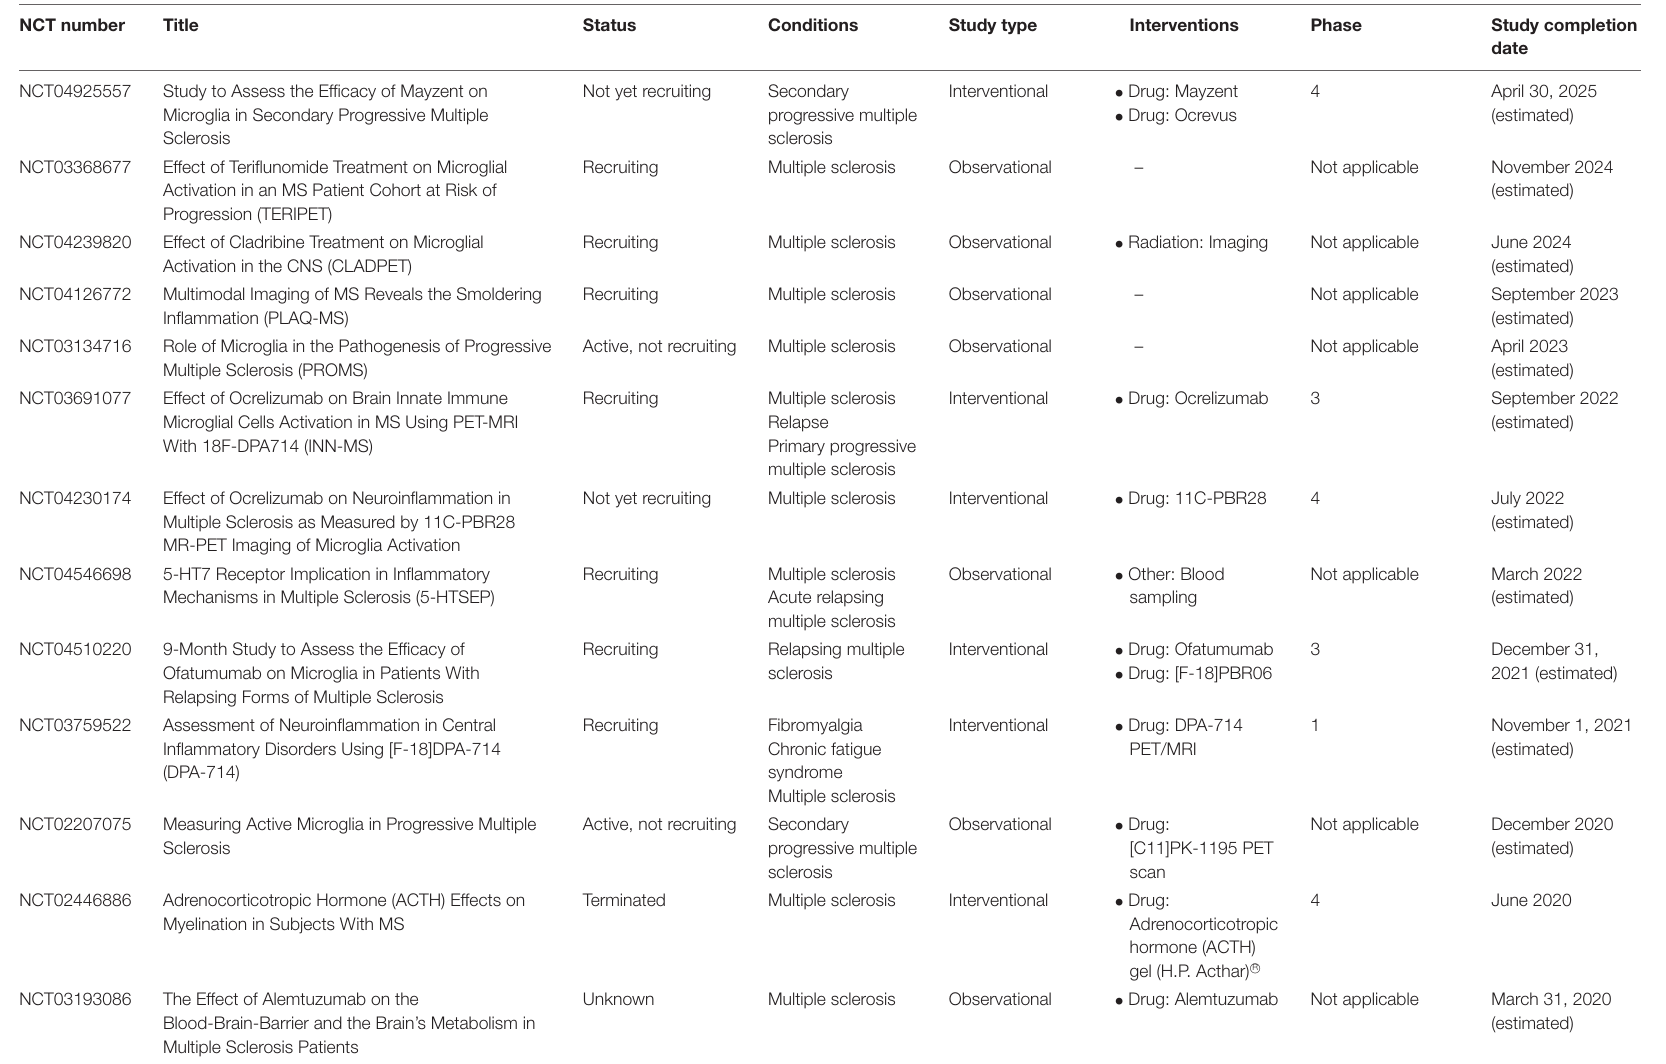
TABLE 1 | Registered clinical trials on https://clinicaltrials.gov focused on microglia and multiple